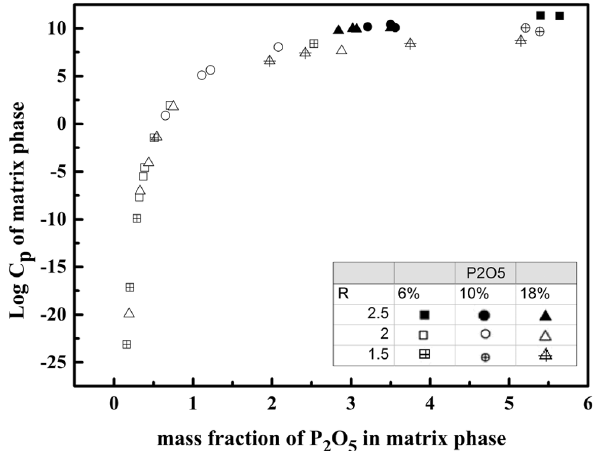
Fig. 9: The effect that phosphorus content of matrix phase on phosphorus capacity of the CaO-SiO 2 -Fe t O-P 2 O 5 slag